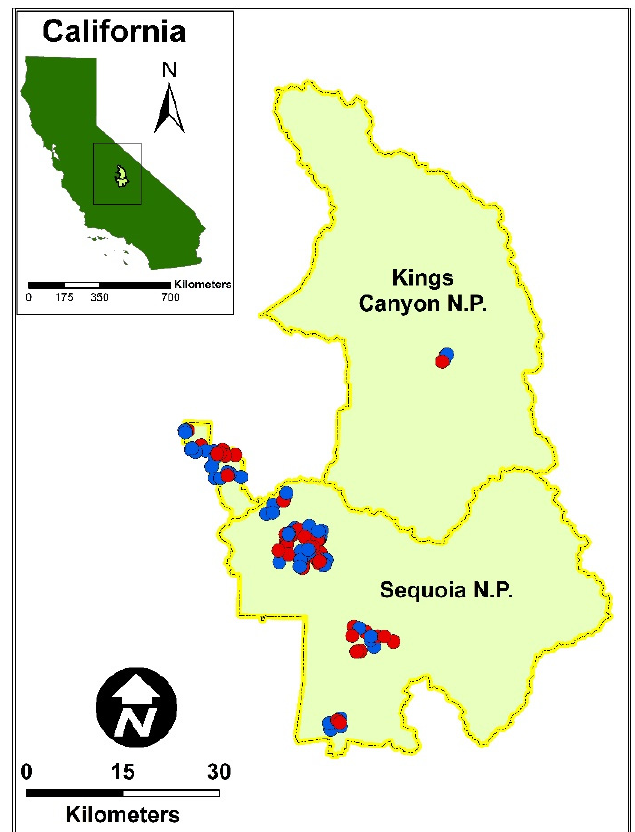
Figure 1. Location of study sites in Sequoia and Kings Canyon National Parks. Red symbols represent locations of burned plots, blue symbols represent locations of unburned plots.